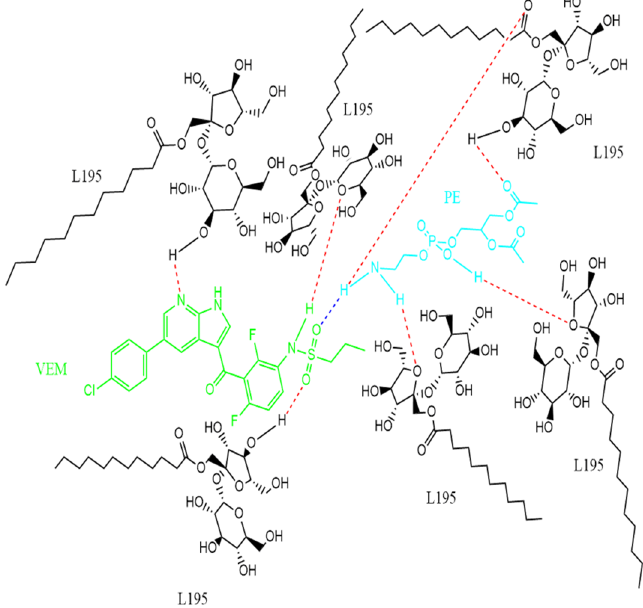
Figure 3. Predicted structure of VEM-PE complex (1:1 ratio) complexed with L195 (1:6.6 ratio) based on CCDC program,wheresinglebluedashedlineindicatedastronghydrogenbondbetweenVEMandPE,whilethered dashed line indicated strong hydrogen bonds between VEM: PE and